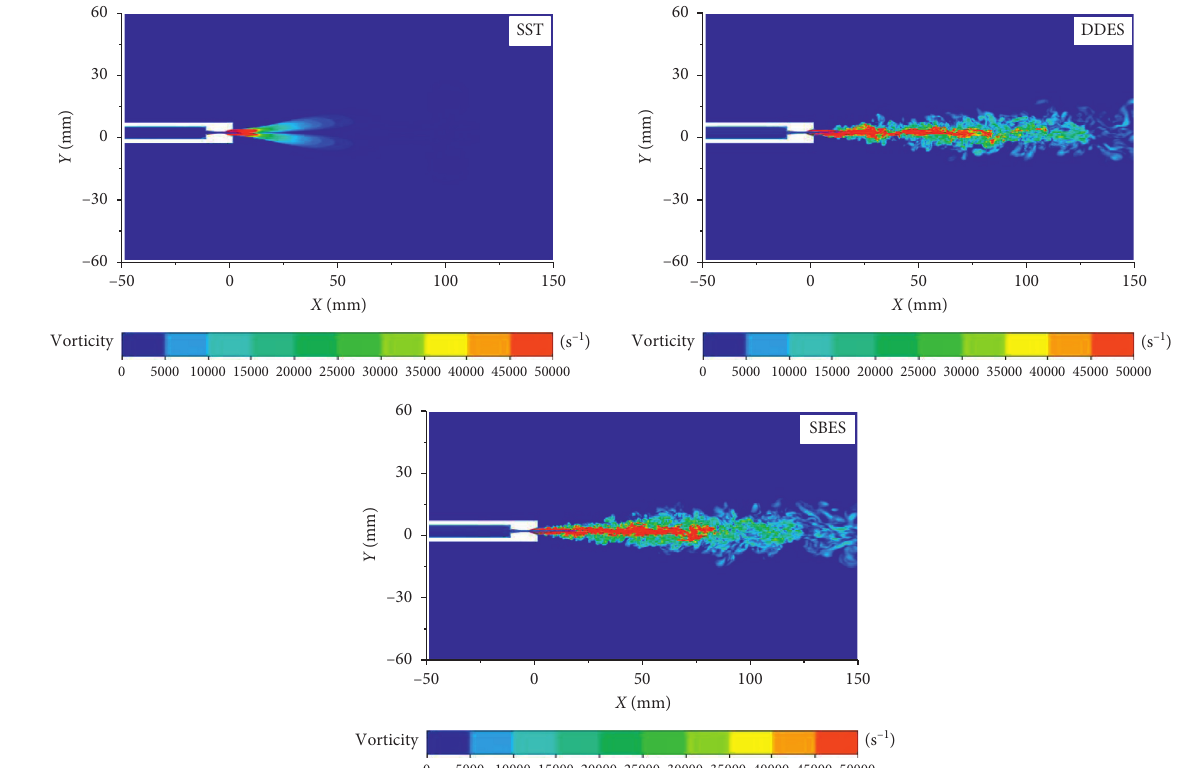
Figure 7: Vorticity of the jet by different turbulence